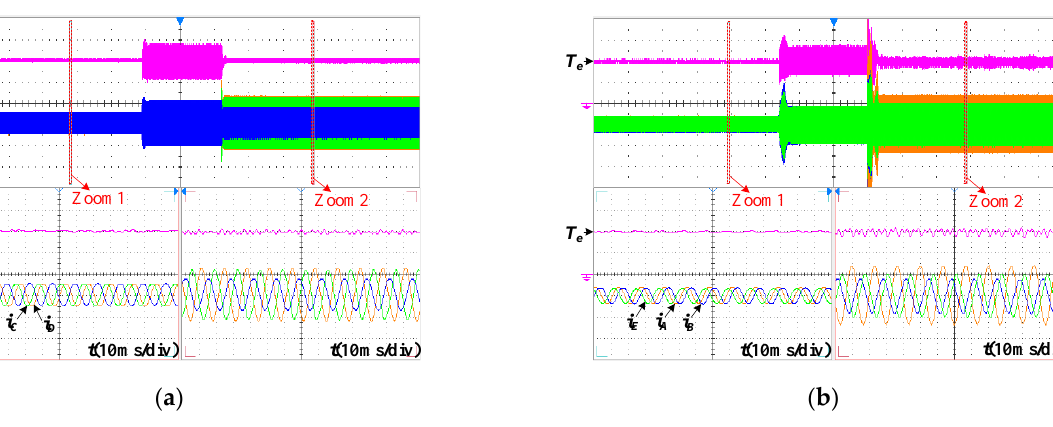
Figure 11. Experimental results in normal operation, fault operation, and two-phase open-circuit fault-tolerant operation. (2 Nm/div, 5 A/div). ( a ) BE two-phase open-circuit fault. ( b ) CD two-phase open-circuit fault.